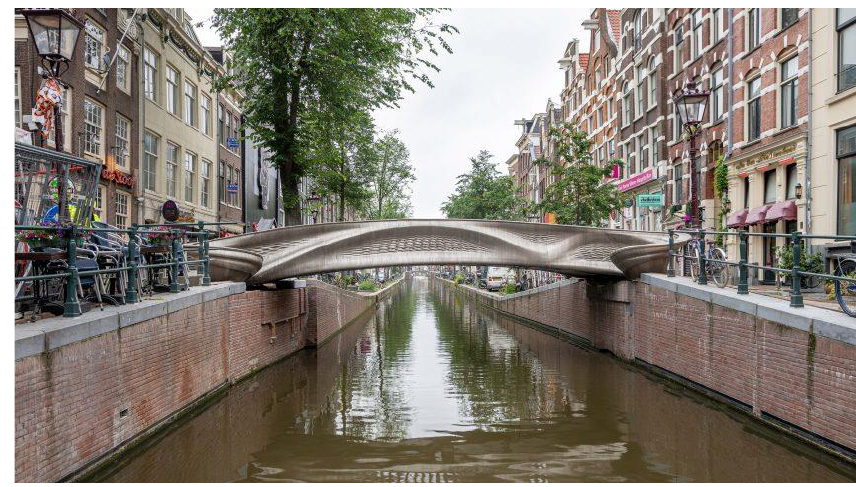
Figure 1. MX3D Bridge in Amsterdam City Center, by Thea van den Heuvel.